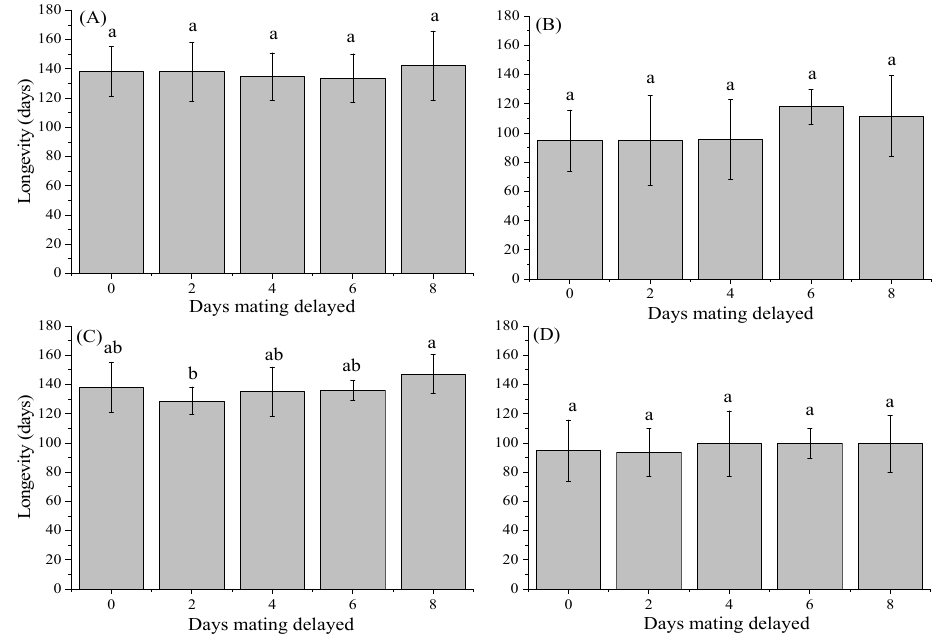
Figure 1. Mean (±SE) longevity of Henosepilachna vigintioctopunctata females after female ‐ delayed Figure 1. Mean ( ± SE) longevity of Henosepilachna vigintioctopunctata females after female-delayed mating (A); males after female ‐ delayed mating (B); females after male ‐ delayed mating (C); and mating ( A ); males after female-delayed mating ( B ); females after male-delayed mating ( C ); and males after male ‐ delayed mating (D). Values (±SE) with the same letter are not significantly different males after male-delayed mating ( D ). Values ( ± SE) with the same letter are not significantly different ( p > 0.05). ( p >